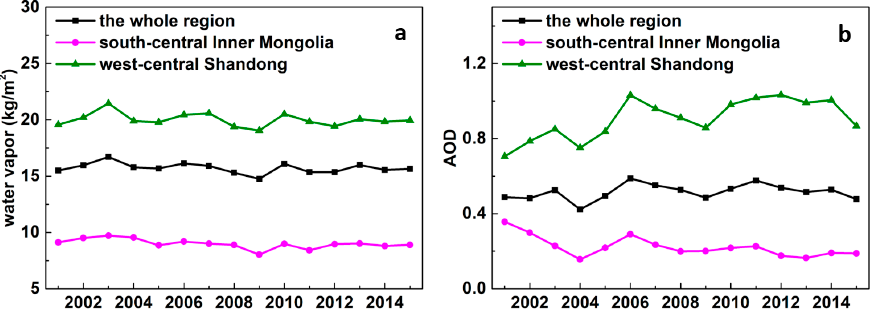
Figure 16. Variations of annual ( a ) water vapor and ( b ) AOD in south-central Inner Mongolia, west- central Shandong, and the whole study area from 2001 to 2015. west-central Shandong, and the whole study area from 2001 to